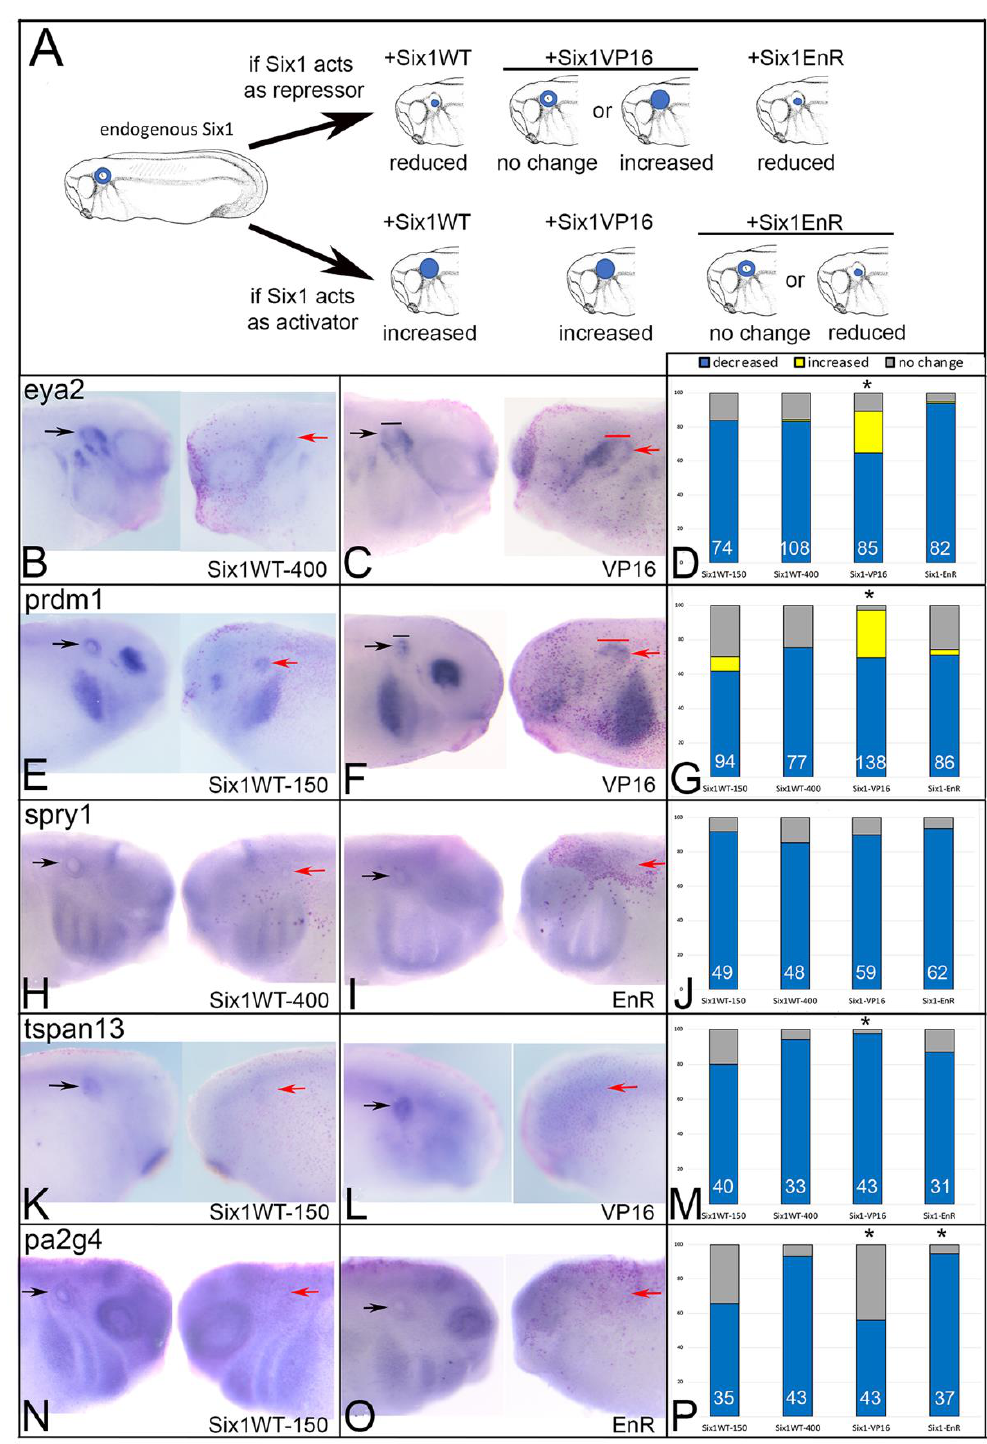
Figure 2. Increased Six1 alters otic gene expression. Transcripts encoding wild-type Six1 (Six1WT, either 150 or 400 pg), activating Six1 (VP16, 100 pg) or repressive Six1 (EnR, 100 pg) were microinjected into blastomeres that contribute to otic structures on one side of embryos containing endogenous levels of Six1. ( A ) The effects on otic vesicle gene expression (blue) were compared between embryos injected with Six1WT mRNA (+Six1WT) versus those injected with either Six1VP16 (+Six1VP16) or Six1EnR (+Six1EnR) mRNAs. If Six1 acts as a repressor (top row), then additional Six1WT should reduce gene expression, Six1VP16 should either cause no change or increase it, and Six1EnR should also reduce it. If Six1 acts as an activator (bottom row), then additional Six1WT should increase gene expression, Six1VP16 should also increase it, and Six1EnR should cause either no change or reduce it. ( B – P ) Gene expression was assayed by ISH for eya2 ( B , C ), prdm1 ( E , F ), spry1 ( H , I ), tspan13 ( K , L ) and pa2g4 ( N , O ). The control, uninjected side of each embryo is on the left and the